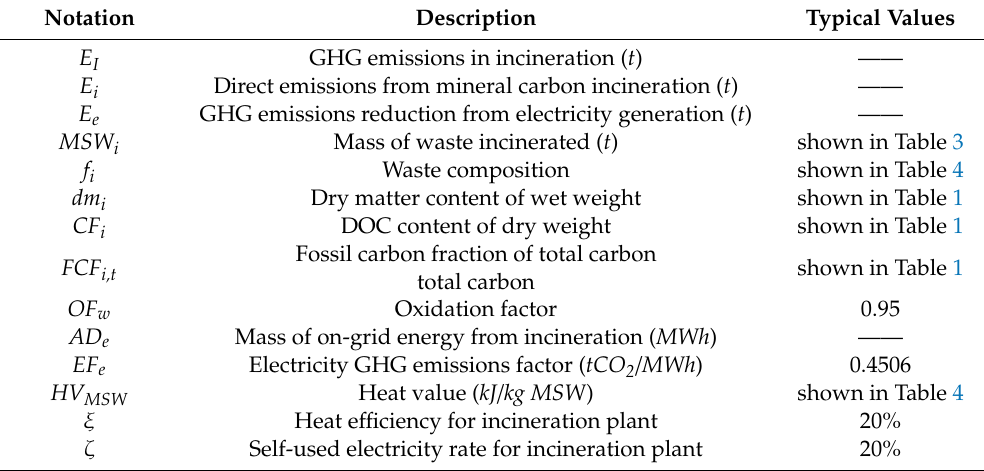
Table 8. Relevant parameters of GHG emissions calculation model for MSW